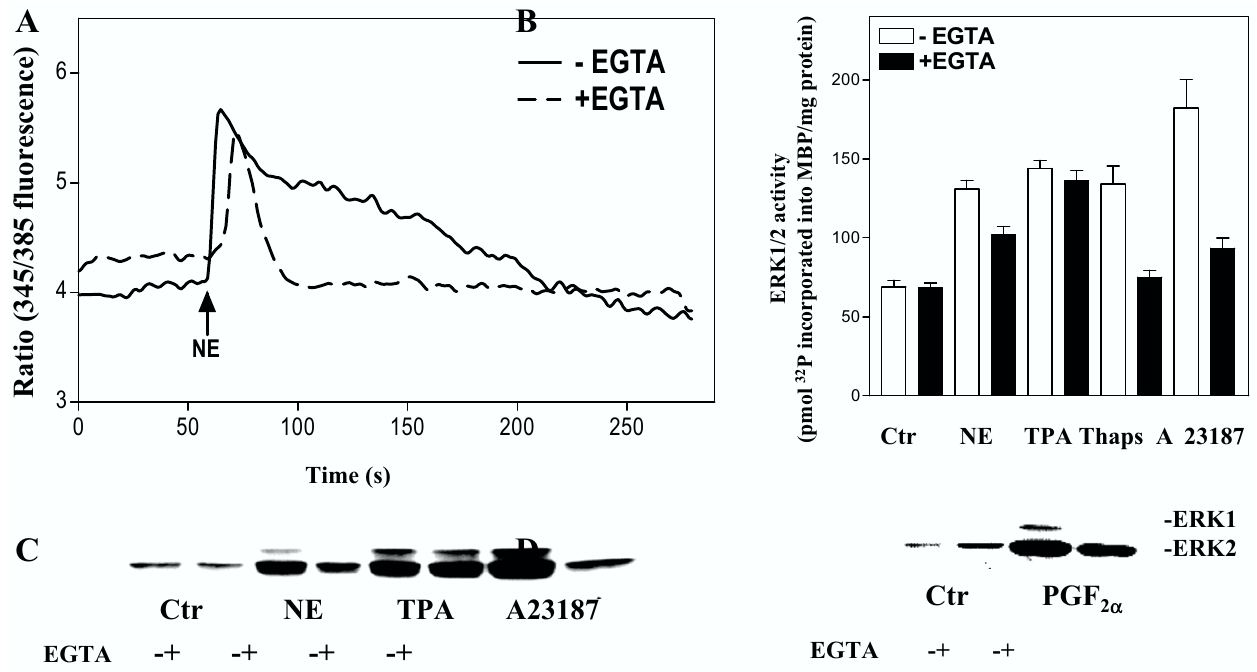
Figure 3 Effect of EGTA on [Ca 2+ ] i and ERK 1/2 activation. A: [Ca 2+ ] i measurements. Hepatocytes were preincubated in Krebs-Ringer- Hepes buffer with or without 5 mM EGTA for 15 min after fura-2 AM loading. After 60 seconds of registration the cells were stimulated with norepinephrine (10 µ M) in the presence of timolol (10 µ M). Results show a typical single cell response. B-D: ERK1/2 responses. Hepatocytes cultured for 3 h were pretreated with timolol (10 µ M) for 30 min and EGTA (5 mM) for 15 min before stimulation with norepinephrine (10 µ M), TPA (1 µ M), thapsigargin (1 µ M), A23187 (10 µ M) or PGF 2 α (10 µ M) for 5 min (in the presence of 0.5 % DMSO). B: Activity measurements of ERK1/2 representing the mean ± S.E.M. of three experi- ments. C, D: Immunoblots using antibody against double phosphorylated, i.e. activated, forms of